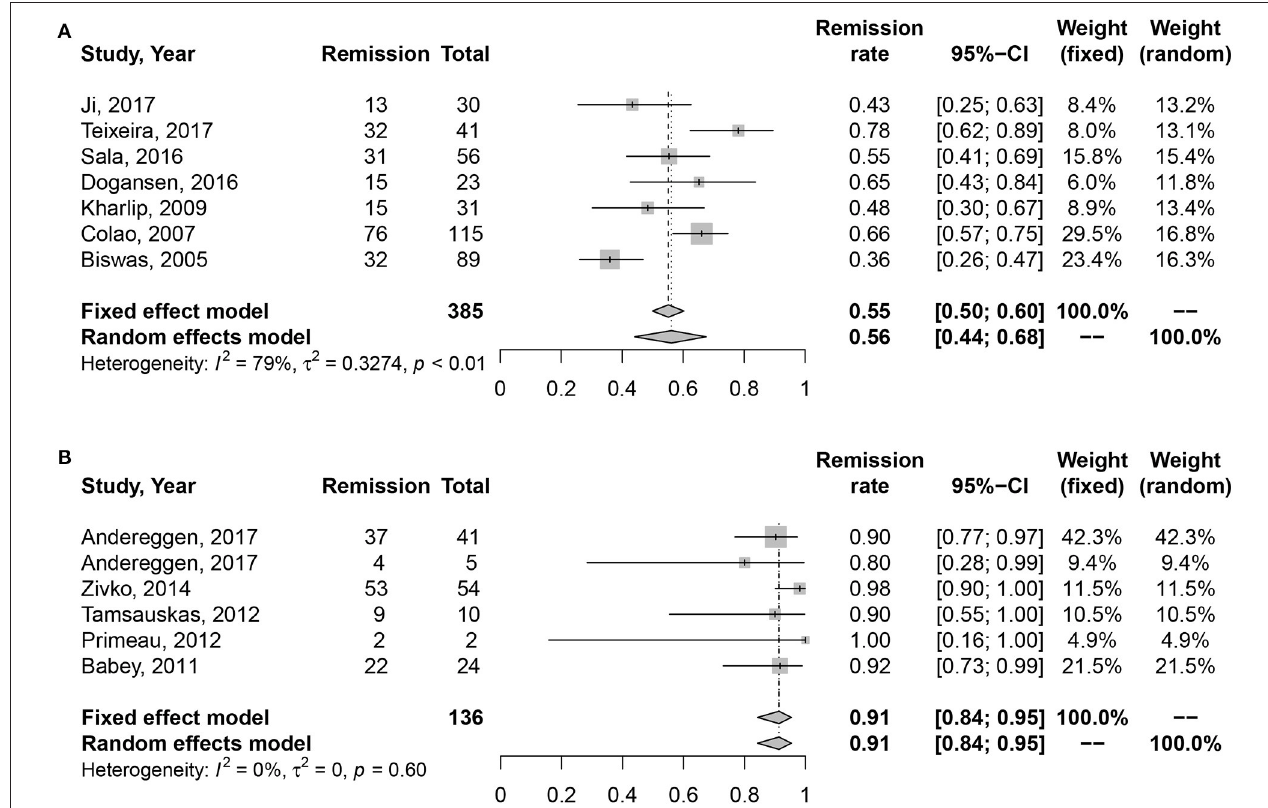
FIGURE 3 | Forest plots describing effects of medication vs. surgery as first-line treatment on the long-term remission rate of microprolactinomas. (A) Long-term remission rate in medication cohort for microprolactinomas. (B) Long-term remission rate in surgery cohort for microprolactinomas.